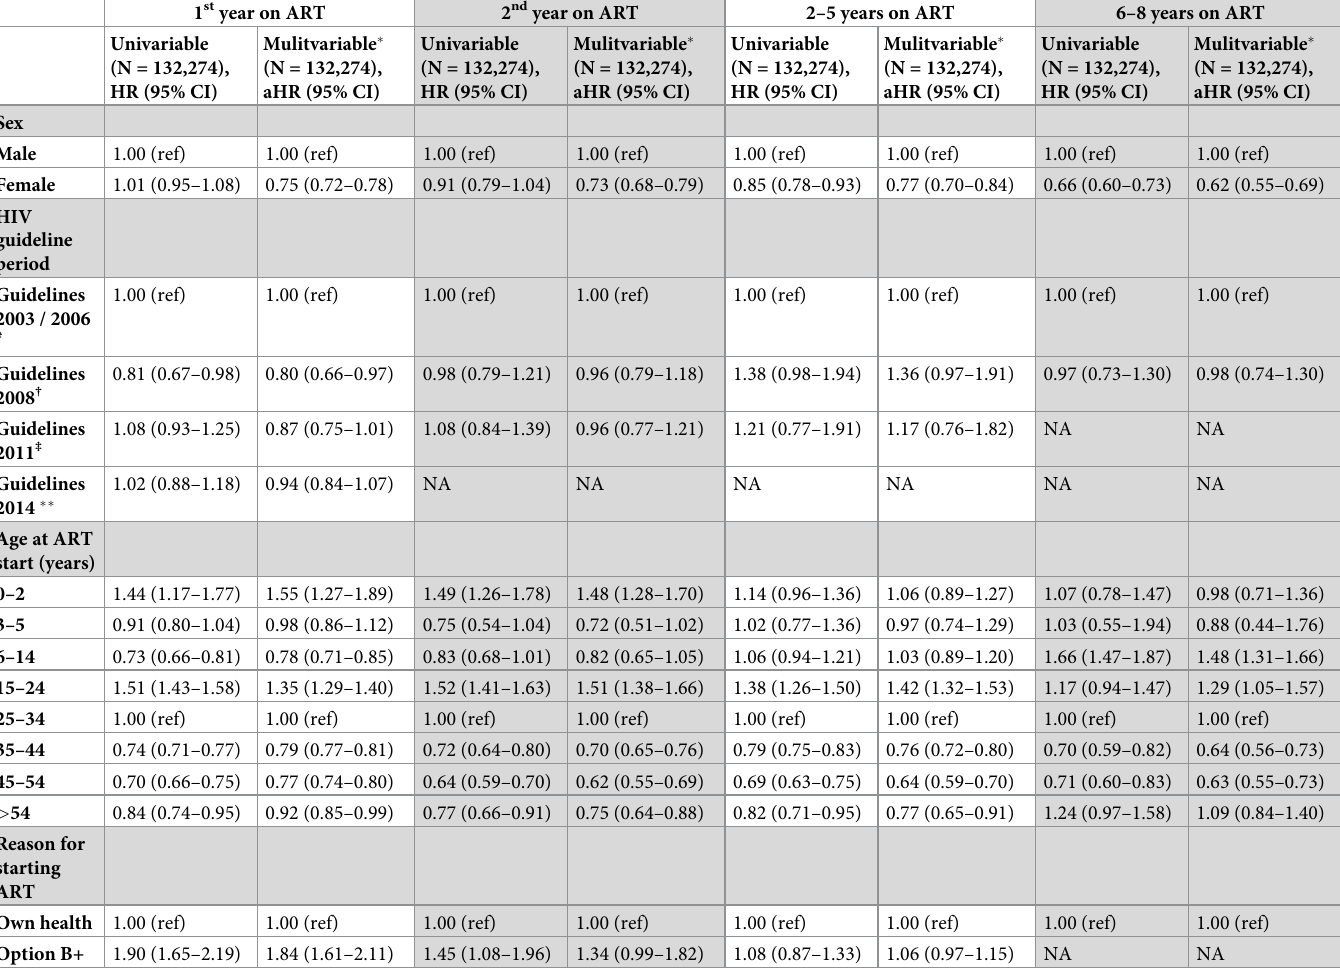
Table 2. Results from Cox Regression Model, Hazard ratios (HR) and adjusted Hazard ratios (aHR) for loss to follow up (LTFU) are shown stratified by years of retention on antiretroviral therapy